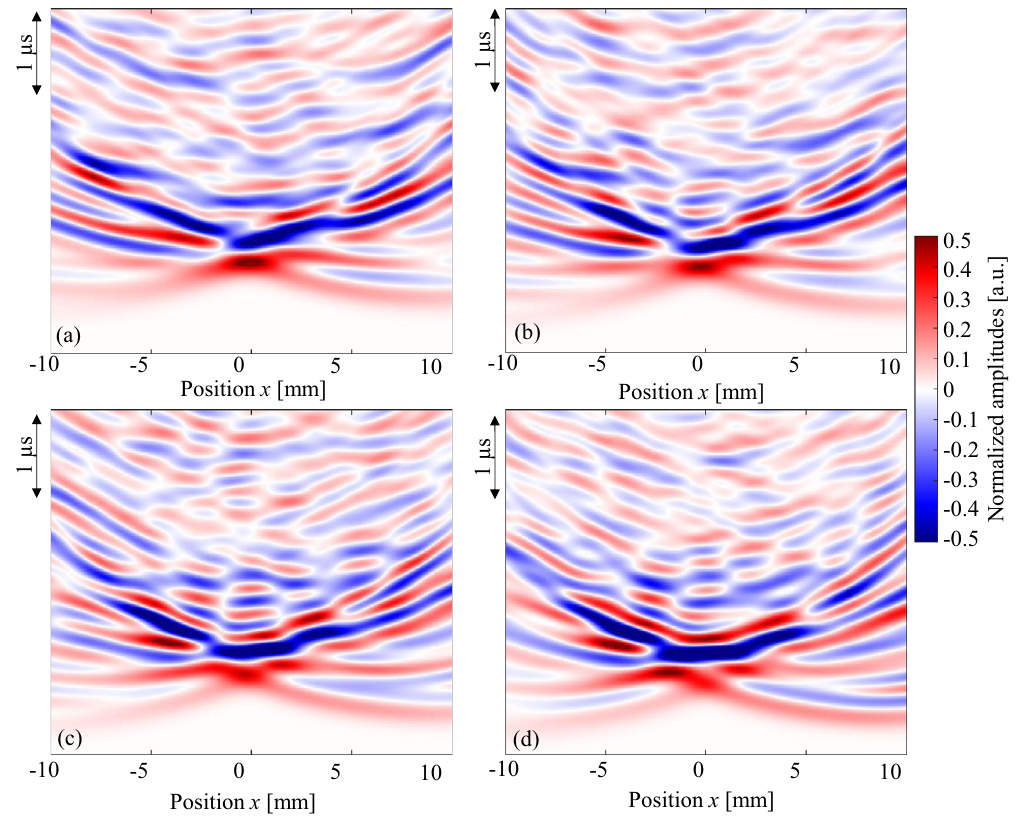
Figure 7. Observed waves at different positions. Ultrasonic waves propagated through models of sample A with different BV/TV values; ( a ) 56%, ( b ) 62%, ( c ) 68% and ( d )